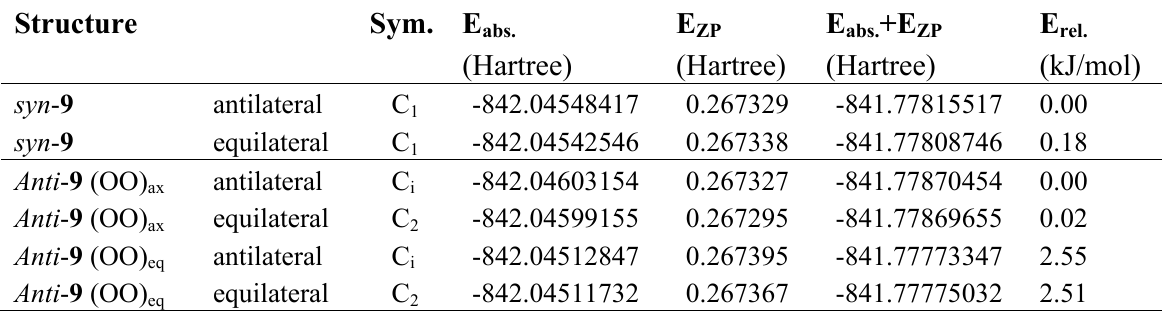
Table 2 . Symmetry and energies a calculated for the model structures 9 .